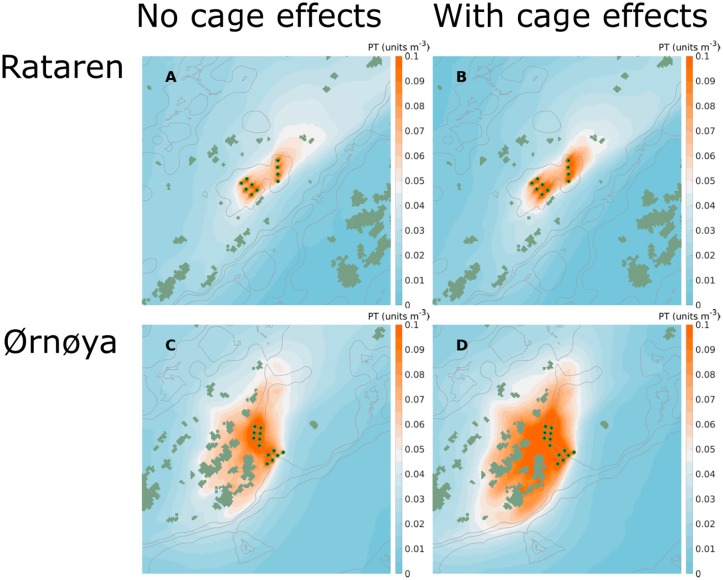
Average simulated dispersal of passive tracers in August-September, 2015.Simulated dispersal of passive tracers from the Rataren (A, B) and Ørnøya (C, D) farms with (B, D) and without (A, C) including the effects of the cages. The results are depth integrated (0 –10 m) means (24 d) of passive tracer concentrations. The gray curves in the background are 30, 50 and 100 m isobaths. The release points of the passive tracer are indicated by green-black dots.